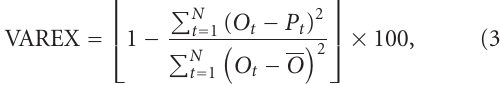
Figure 3: RMS error for various numbers of neurons and for di ff erent models using datasets